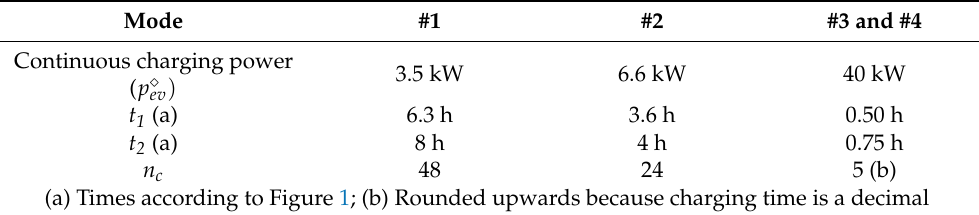
Table 1. EV battery charging profile